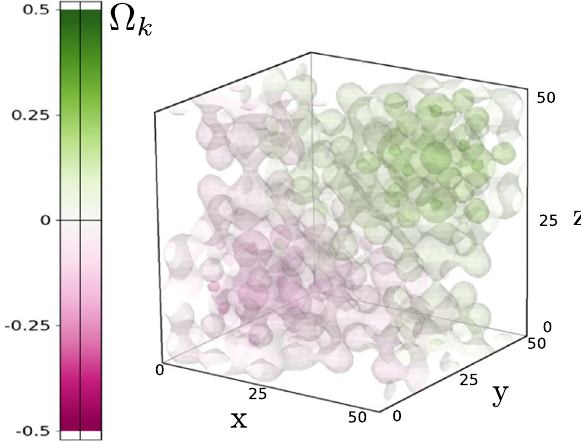
Fig. 7 The isosurfaces of constant Ω k parameter evaluated at the age of the EdS universe t ( EdS ) . The domain is the elementary 0